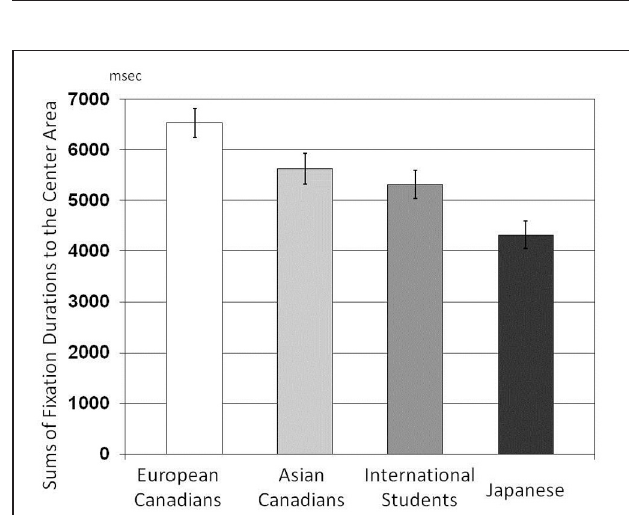
FIGURE 7 | Comparison of sums of fixation durations to the Center Area for the four cultural